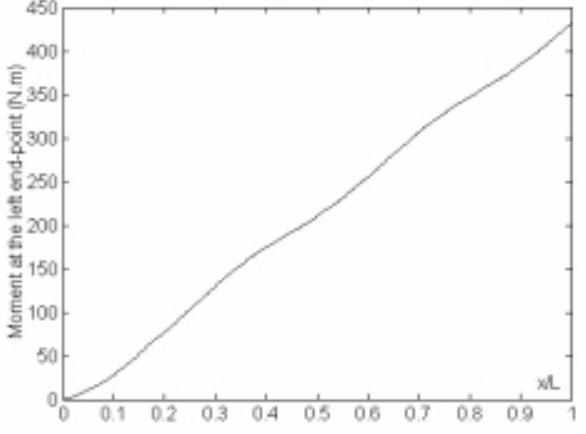
Fig. 8. Moment at the left end-point of a fixed-free beam with β = 0 . 15 under a moving force with v = 50